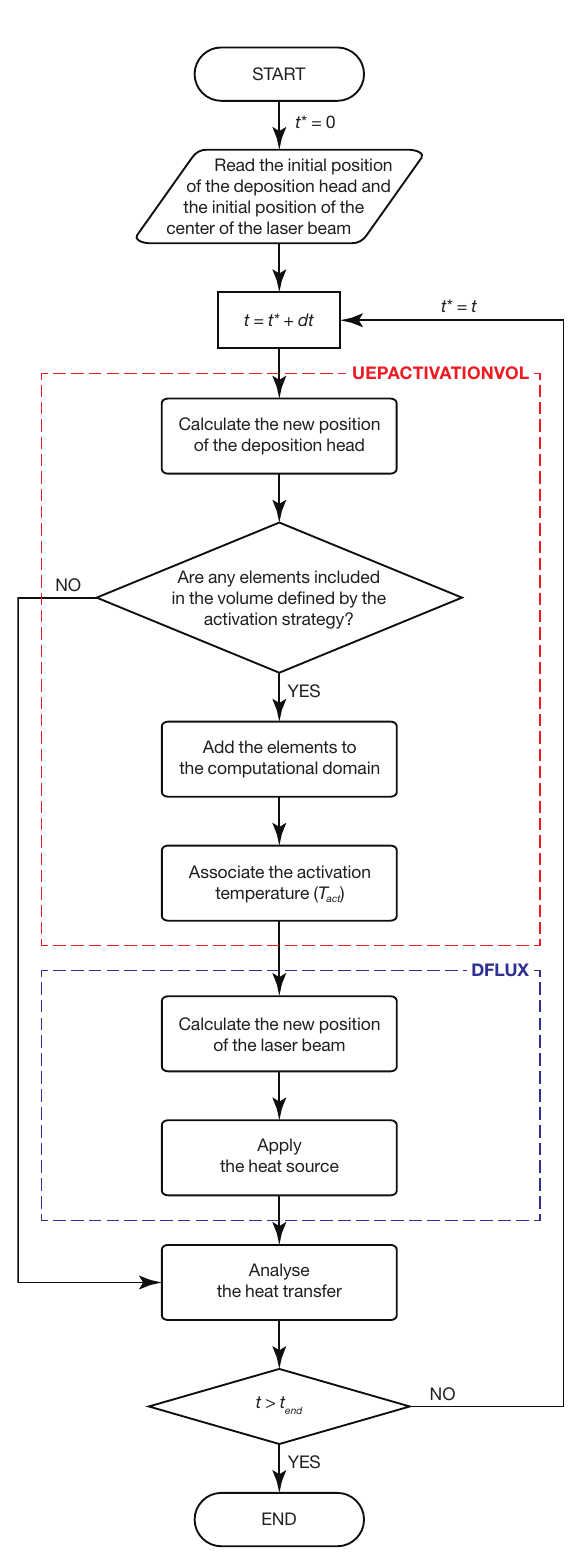
Figure 4. Flowchart of the numerical